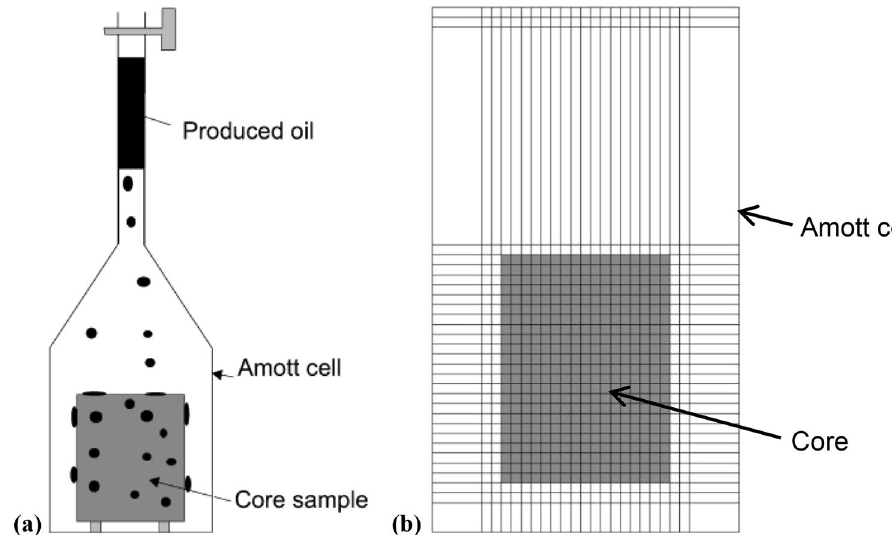
Fig. 1 a Experimental setup of spontaneous imbibition and b simulation model for history